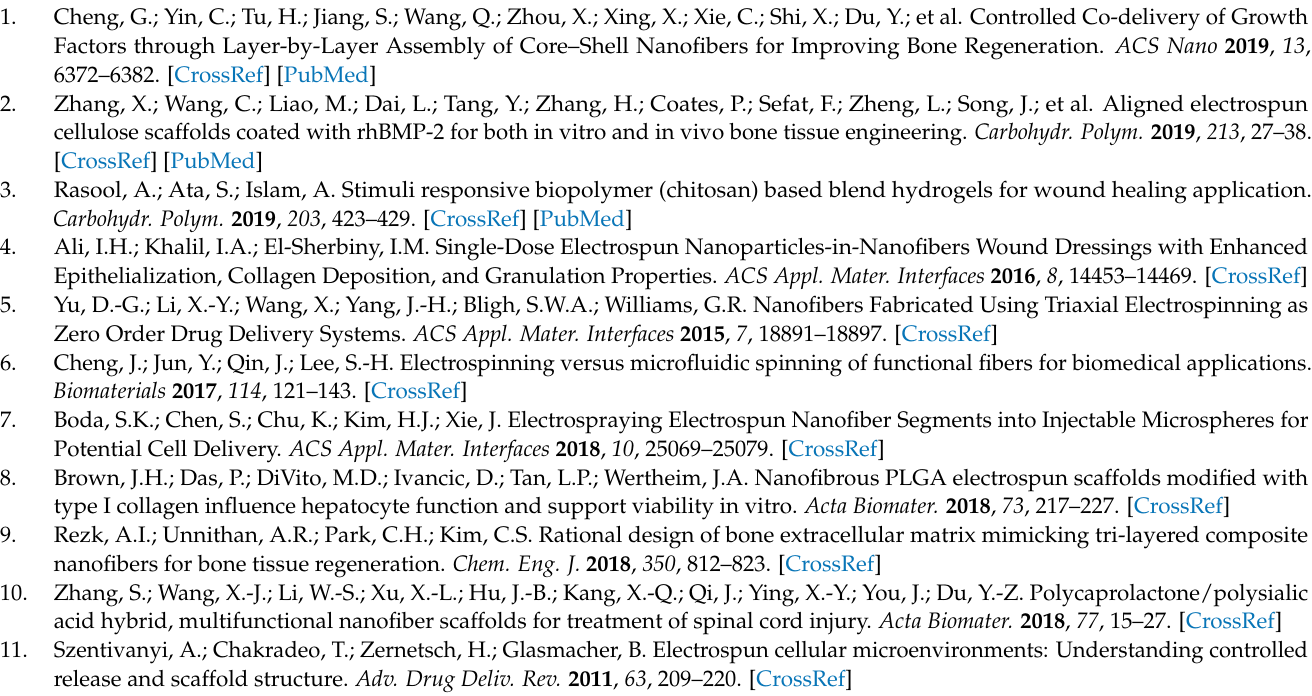
fabrication of core-shell nanofiber, Figure S3: Image and schematic of polymer jets drop on ground, Figure S4: Image and schematic of polymer jets collect on rotational reservoir, Figure S5: Image and schematic of only few continuous fibers collect on collector wall, Table S1: Fabrication of nanofibers via co-axial centrifugal spinning with various